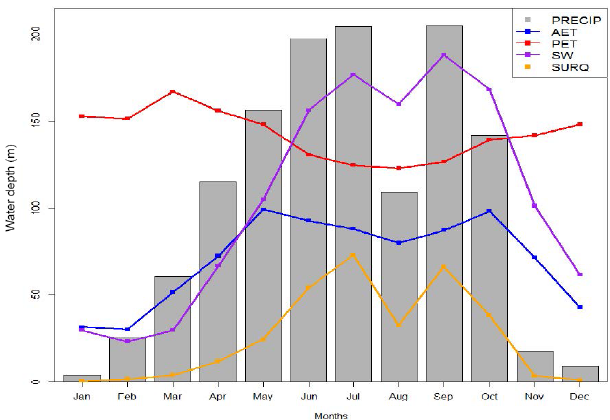
Figure 12. Seasonal fluctuation of water balance components at the outlet of the watershed located in